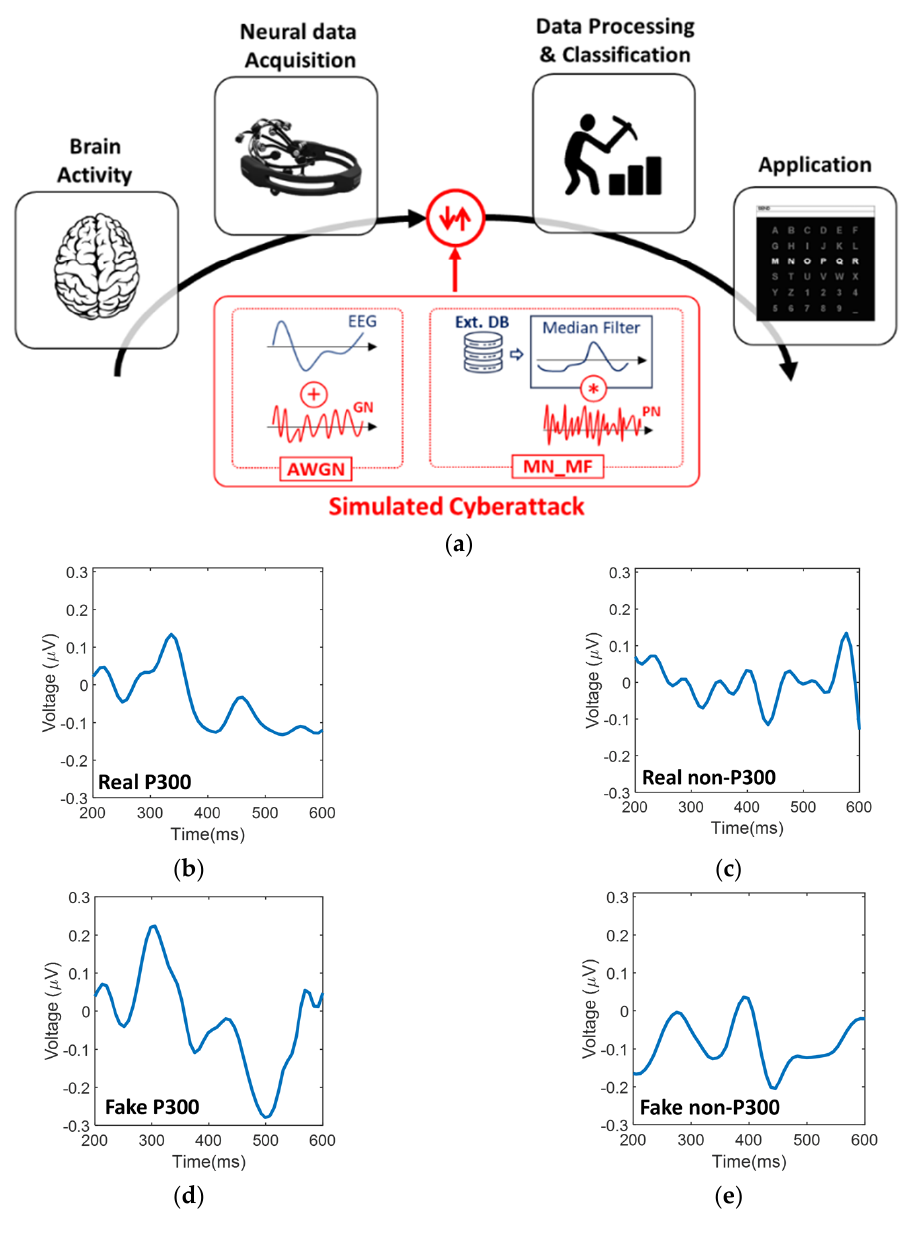
Figure 1. ( a ) BCI processing chain from acquisition to application with simulated cyberattacks on raw data between the neural acquisition and transmission and the BCI framework. ( b ) Example of real P300 and ( c ) real non-P300 signals (subject 1, channel P4, averaged over 200 acquisitions). ( d ) Example of fake P300 and ( e ) fake non-P300 signals (MF3,001, averaged over 200 signals).